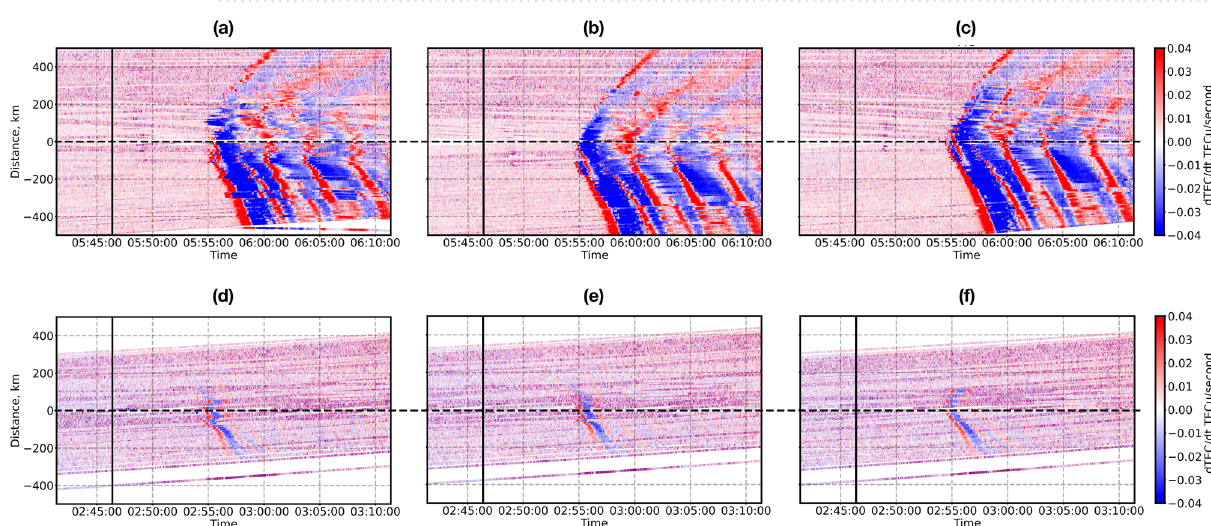
Figure 7. Near-real-time travel time diagram (NRT-TTD) plotted by using dTEC/dt data for the Tohoku ( a – c ) earthquake (satellite G26) and Sanriku ( d – f ) earthquake (satellite G07). In panels ( a , d ) the distance is calculated with respect to the earthquakes’ epicenters as estimated by the USGS, in panels ( b , e )—with respect to the maximum co-seismic uplifts; ( c , f )—with respect to the ionospheric localization as shown in Fig. 5d, e and 6d, e. The color scale is shown on the